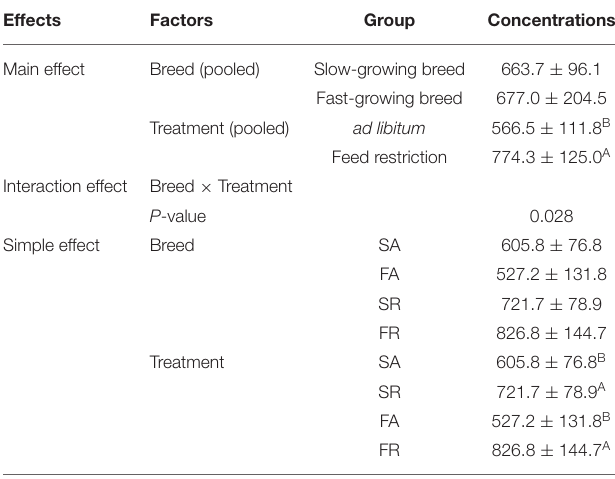
TABLE 2 | Effects of feed restriction on plasma dopamine concentration between slow- and fast-growing